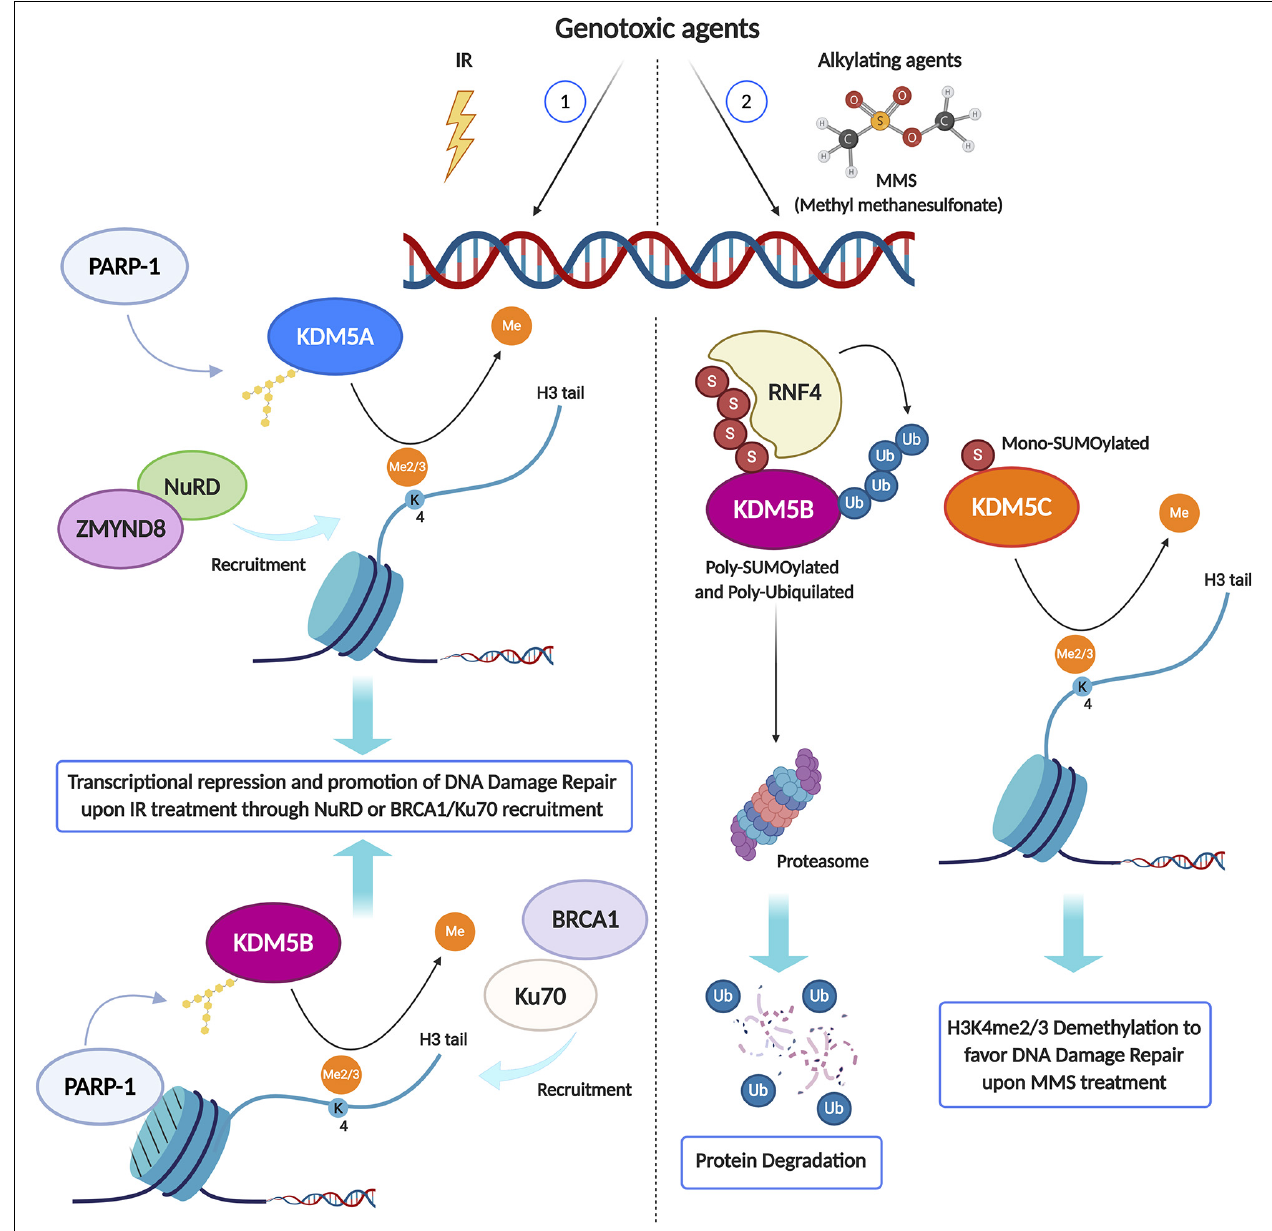
FIGURE 2 | KDM enzymes may play different roles in the DNA Damage Response (DDR) depending on the genotoxic agent type. Upon IR treatment (1), PARP1 activity is required to recruit both KDM5A and KDM5B at DSB sites, where they catalyze the local demethylation of H3K4me2/3, crucial for the recruitment of transcriptional repressive complex like ZMYND8/NuRD or DDR key proteins, including BRCA1 and Ku70. Conversely, in response to alkylation damage by MMS (2), Poly-SUMOylated KDM5B is Poly-ubiquitylated by the SUMO-targeted ubiquitin ligase RNF4 and degraded by the proteasome, while JARID1C is Mono-SUMOylated and recruited to the chromatin to demethylate histone H3K4me2/3. Created using